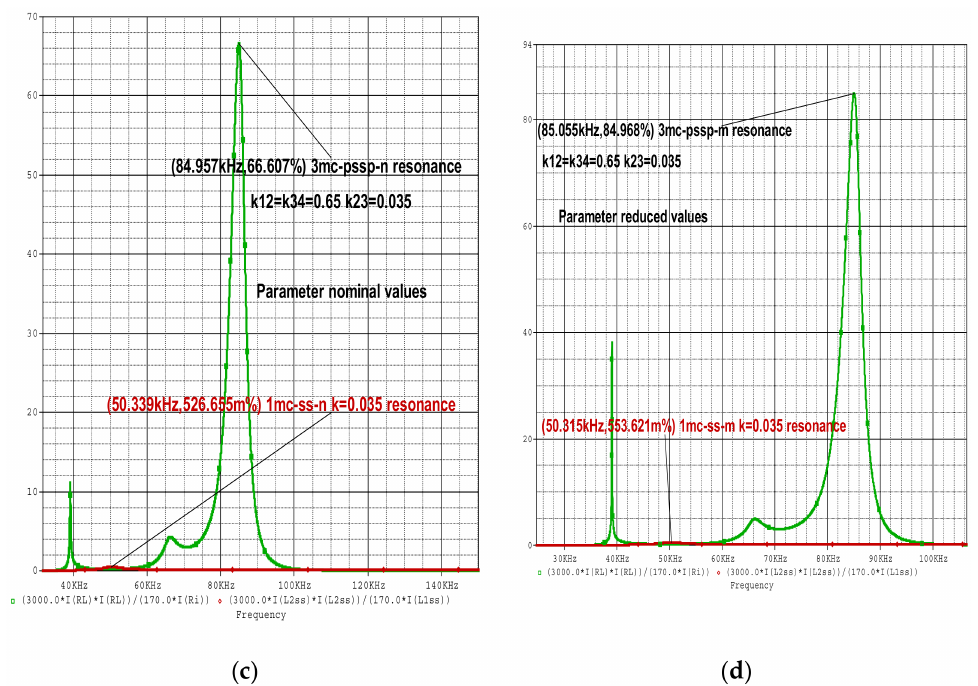
Figure 5. The dependence on the frequency η 21 from the source to the load for ( a ) Connections ss-3mc- n and ss-1mc-n; ( b ) Connections ss-3mc-m and ss-1mc-m, whereas the values of the resistances R L